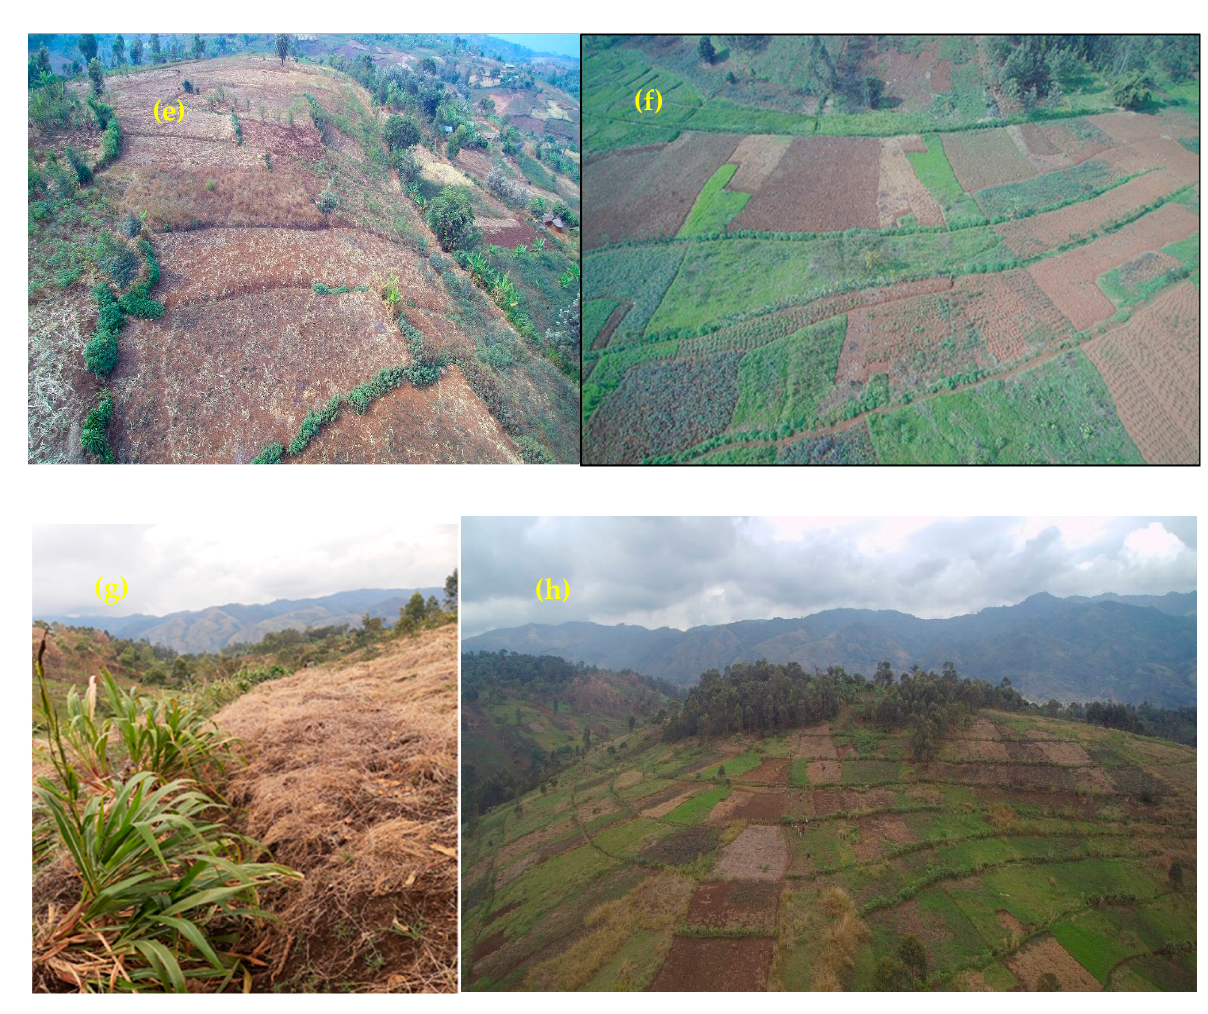
Figure 7. Predominant soil and water conservation practices in South-Kivu highlands, eastern DRC: ( a ) Terraces, ( b ) Zaï pits, ( c ) ridges, ( d ) mulching, ( e – h ) hedges with green manure and forages as implemented by smallholder farmers of Kabare, eastern DRC with a support from UEA scientists under Food Security Project (FSP) in partnership with Mercy Corps, World Vision, HarvestPlus, and Action pour la Paix et la Concorde